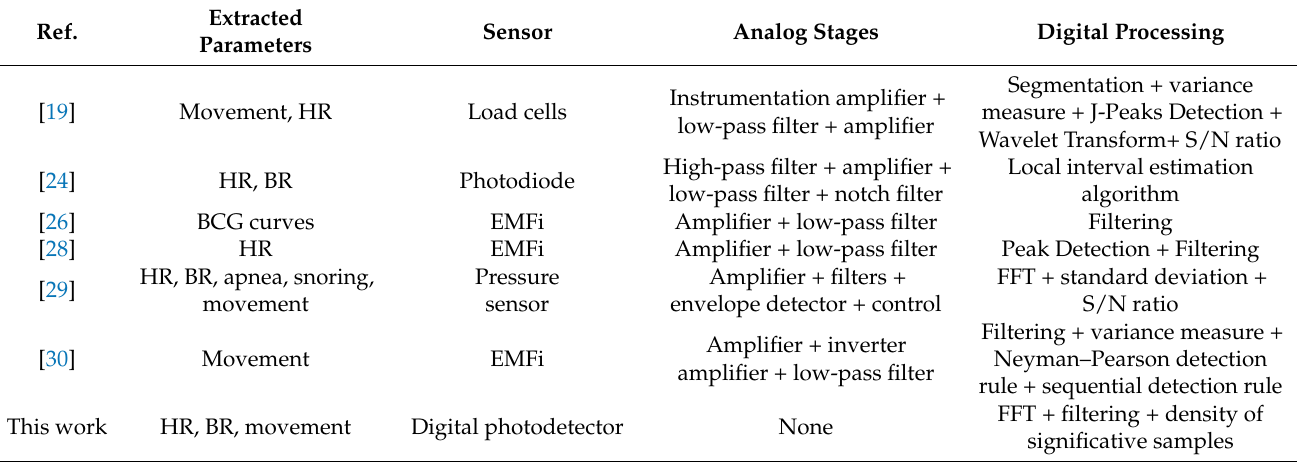
Table 2. Comparison of analog and digital stages of this work with recently published BCG systems.